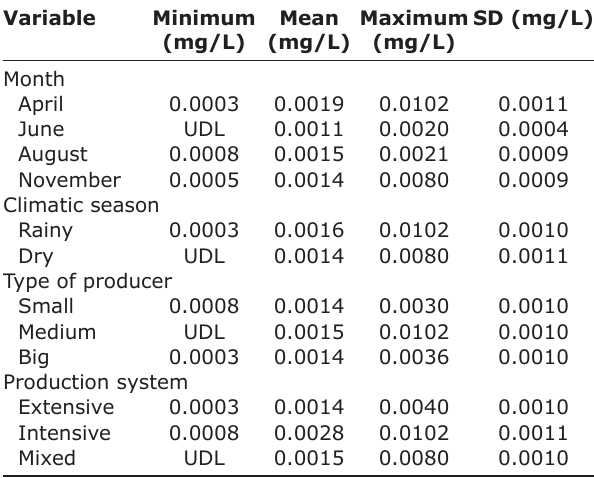
(Table-1), both from Chone Canton of Manabí.